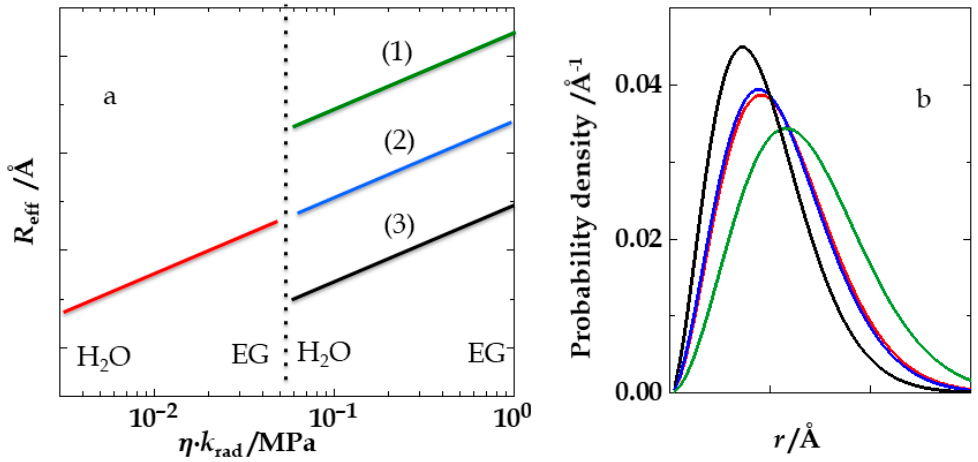
Figure 6. ( a ) The effective donor-acceptor distance ( R eff , relative scale) in donor/acceptor labeled peptides plotted against η k rad . The dotted vertical line marks the point where the viscosity switches back from high to low ethylene glycol content and where a donor of high radiative lifetime is exchanged for one with low radiative lifetime. The three possible cases are (1), (2), and (3). (1) The end-to-end distances in the experimental peptide shorten upon addition of ethylene glycol, such that the switch back to low ethylene glycol content shows an up-jump of the effective distance (red and green line). (2) The distances are completely independent of the ethylene glycol concentration (red and blue line). (3) The peptide expands upon addition of ethylene glycol, such that the switch back to low ethylene glycol content shows a down-jump of the effective distance (red and black line). ( b ) The distance distributions (probability density plotted against relative donor-acceptor distance) that correspond to the three cases in ( a ) shown in corresponding colors. For instance, case (2) points to virtually identical distance distributions (red and blue) that do not change with the ethylene glycol concentration.